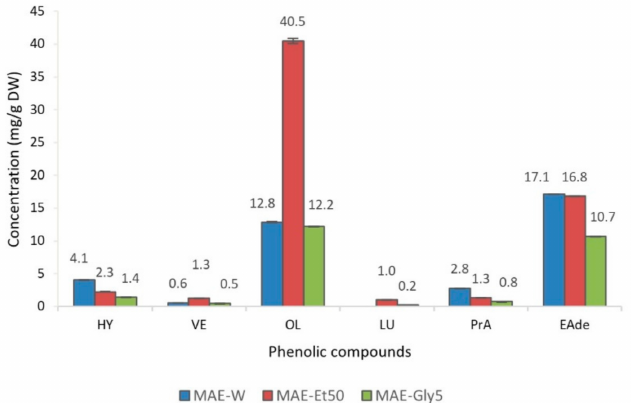
Figure 6. Concentration (mg/g dry weight) of phenolic compounds in microwave-assisted extraction (MAE) extracts, using water (MAE-W), 50% ethanol (MAE-Et50) and 5% glycerol (MAE-Gly5) as solvents. Abbreviations: HY, hydroxytyrosol; VE, verbascoside; OL, oleuropein; LU, luteolin; PrA, protocatechuic acid; EAde, elenolic acid derivatives (sum of 3 derivatives